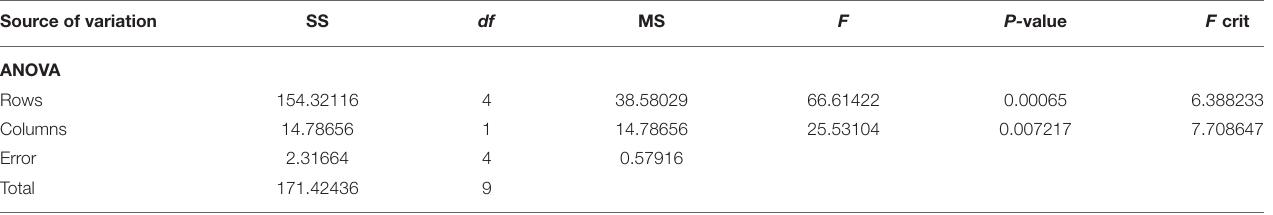
TABLE 10 | Statistical analysis of Rabi season from Table 11 .